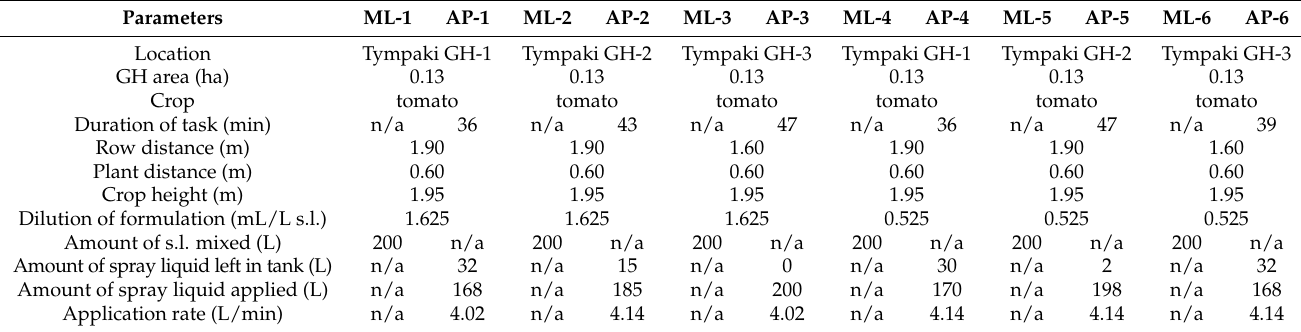
Table 2. Field trial parameters and